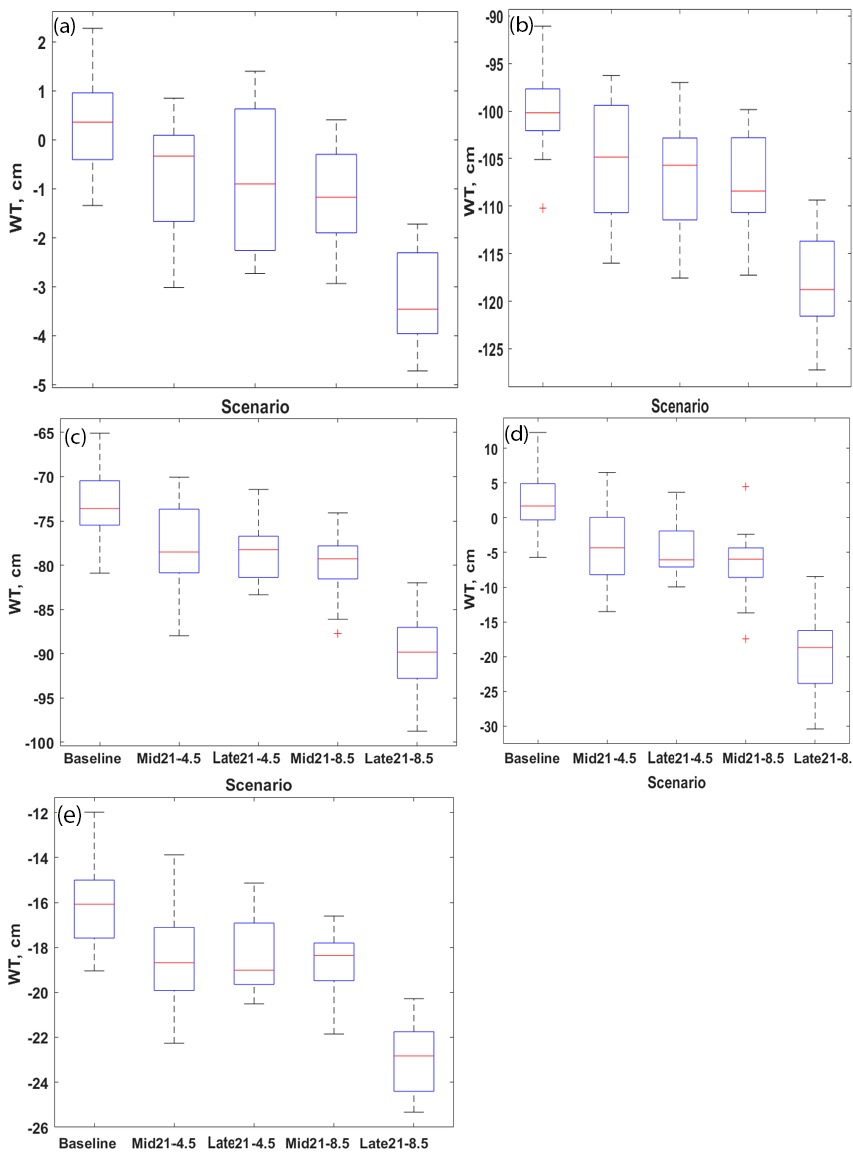
Figure 5. Mean predicted annual water table of 20 GCMs in five wetlands in the SE United States (unit: cm), where (a) is site AR (Alligator River National Wildlife Refuge in North Carolina), (b) is site LP (loblolly pine plantation in North Carolina), (c) is site FL–UP (upland in Florida), (d) is site FL–WET (wetland in Florida), and (e) is site SC (wetland in South Carolina). The baseline is 1980–1999, the historical